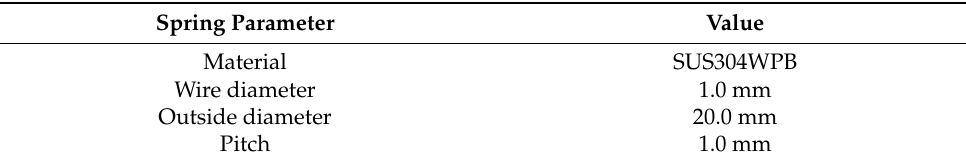
Figure 2. Linear-extension soft pneumatic actuator. Table 1. Specification of the spring.